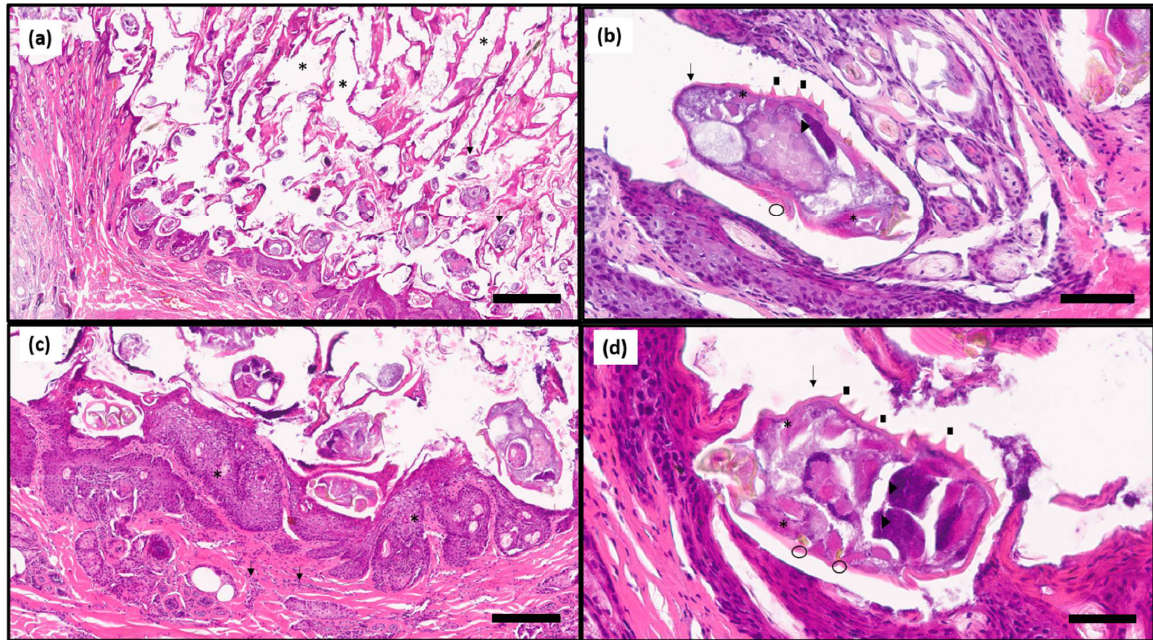
Figure 3. ( a ): The stratum corneum is expanded by an up to 4 mm thick layer of parakeratotic hyperkeratosis embedding numerous tunnels (three of them are marked with asterisks) that contain many cross and tangential sections of arthropods (two of them are marked with black arrows) Barr = 600 µm. ( b , d ): Arthropods (black arrows) are approximately 250 × 150 µm in size, have a thick chitinous exoskeleton, dorsal spines (black squares), a hemocoel, striated muscle (asterisks), jointed appendages (circles) and digestive and reproductive organs (arrow heads). Numerous eggs with a tan shell obliterated with basophilic globular material are visible. Barr = 60 and 80 µm, respectively. ( c ): Associated with the parasites, the superficial dermis is diffusely expanded by moderate numbers of perivascular to interstitial neutrophils, macrophages, eosinophils, fewer lymphocytes and plasma cells (arrow). The epidermis is moderately hyperplastic (asterisk). Barr = 200 µm. H&E stain.